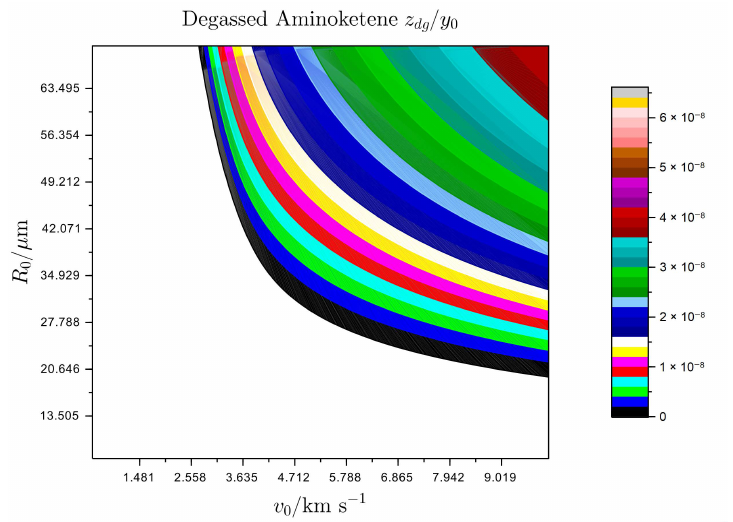
Figure 13. Contour lines of the relative fraction of degassed aminoketene z dg / y 0 (6.00 × 10 − 9 ≤ z dg / y 0 ≤ 5.40 × 10 − 8 ) calculated with L = 1.3 × 10 − 11 m, D 0 = 1.0 × 10 − 12 m 2 s − 1 , and θ 0 = 45.0 deg versus the initial velocity and radius of micrometeoroids with 0.5 ≤ v 0 ≤ 10.0 km s − 1 and 7 ≤ R 0 ≤ 70 µ